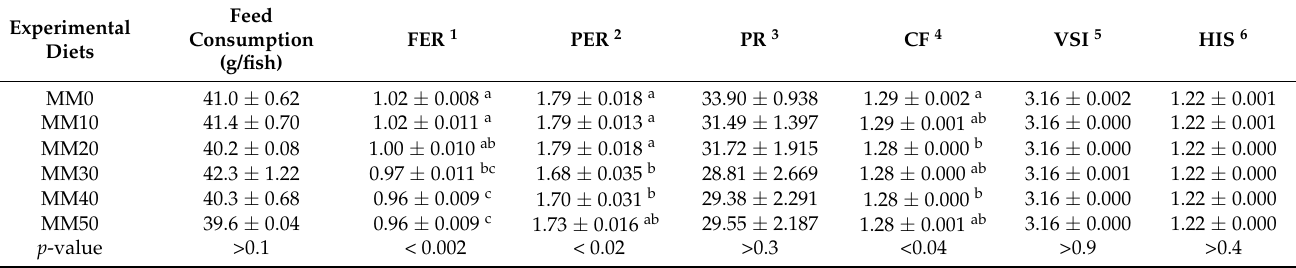
Table 4. Feed consumption (g/fish), feed efficiency ratio (FER), protein efficiency ratio (PER), protein retention (PR), condition factor (CF), viscerosomatic index (VSI), and hepatosomatic index (HSI) of olive flounder fed the experimental diets for 56 days.